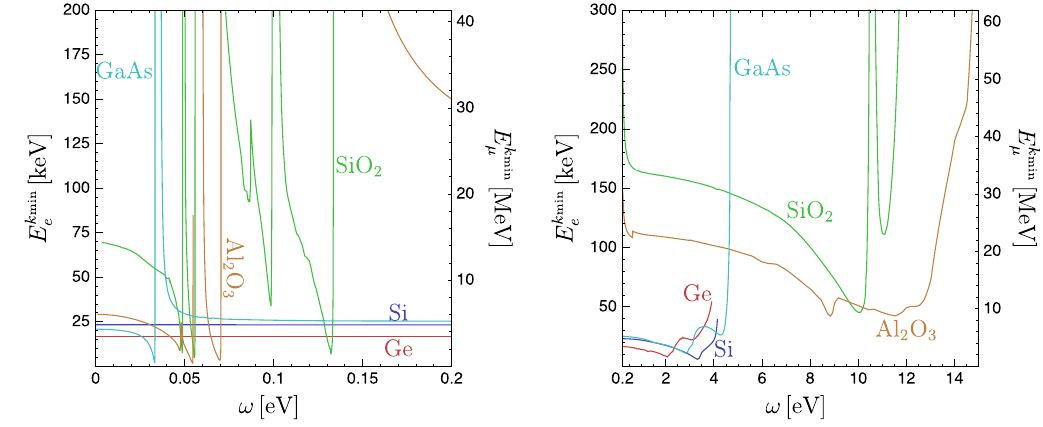
FIG. 4. Minimal electron and muon kinetic energies required to emit Cherenkov photons of frequency ω obtained from Eq. (2.3), in the frequency ranges 0 ≤ ω ≤ 0 . 2 eV (left) and 0 . 2 ≤ ω ≤ 15 eV (right), in Si, Ge, α -quartz, sapphire, and GaAs. The jumps in the minimal kinetic energies in the range ω ≤ 0 . 2 eV for quartz, sapphire, and GaAs are due the strong dielectric response of polar materials for photon energies close to the lattice modes. The jump in the minimal energy for quartz at approximately 11 eV is due to an accidental coincidence of the refraction index and the extinction coefficient at those energies, n ∼ κ , that leads to a small value of Re ϵ ð ω Þ ; cf. Eq.